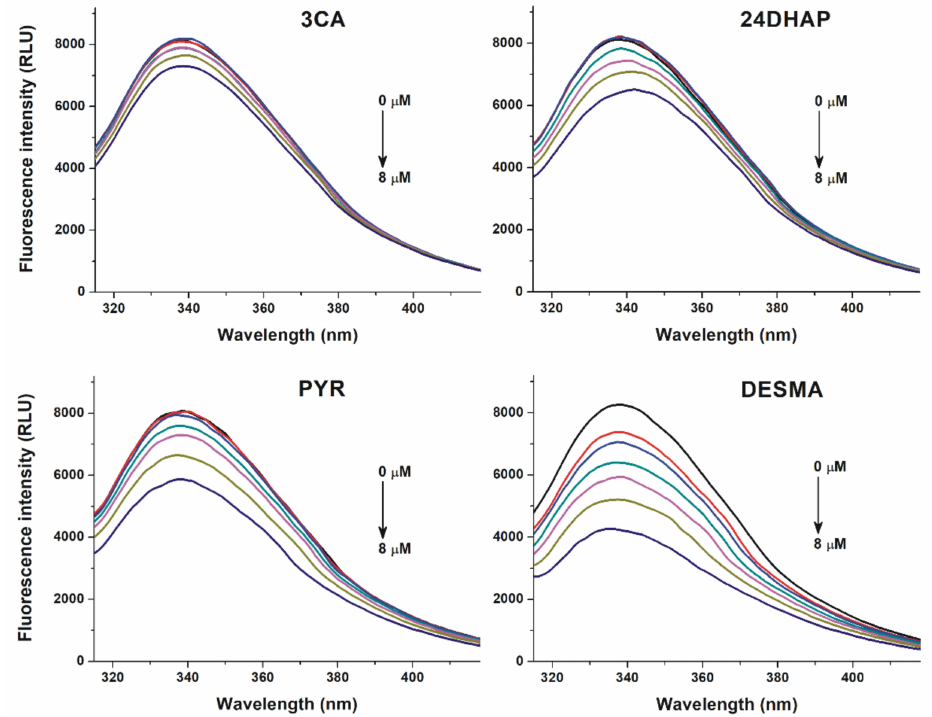
Figure 2. Fluorescence quenching e ff ects of colonic flavonoid metabolites. Representative emission spectra of HSA (2 µ M) in the presence of increasing concentrations (0, 2, 3, 4, 5, 6, and 8 µ M) of 3-coumaric acid (3CA), 2,4-dihydroxyacetophenon (24DHAP), pyrogallol (PYR), and O -desmethylangolensin (DESMA) in PBS (pH 7.4; λ ex = 295 nm).